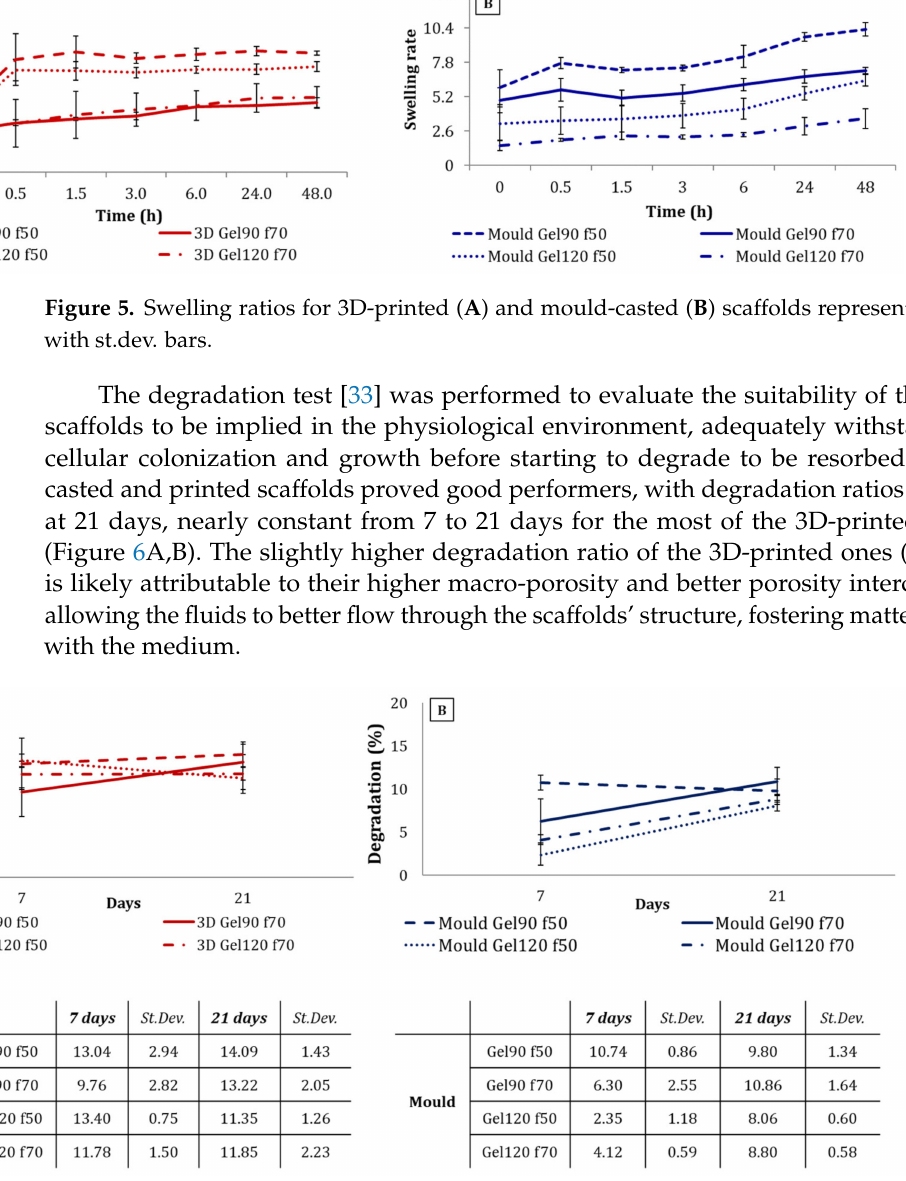
Figure 6. Degradation of 3D-printed and mould-casted scaffolds at 7 and 21 days, represented as mean with st.dev. bars. ( A ) degradation of 3D printed scaffolds; ( B ) degradation of mould casted